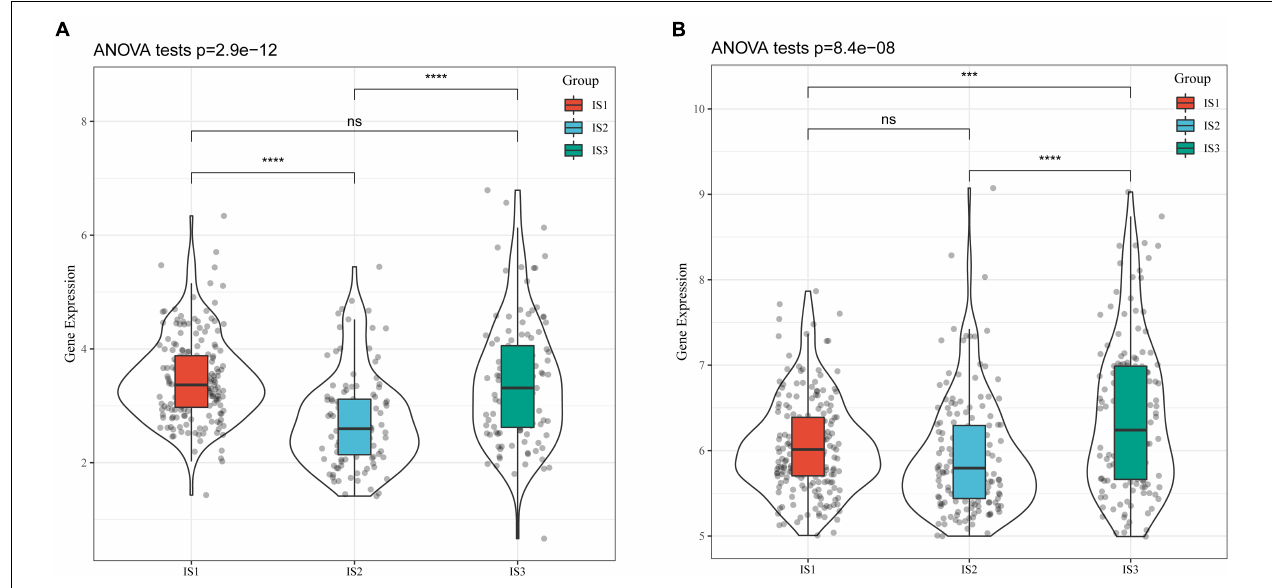
FIGURE 4 | Differential analysis of tumor markers in different immune subtypes. (A) Differences in the expression of CA199 in each subtype of the TCGA-COAD cohort; (B) Differences in the expression of CA199 in each subtype of the GSE39582 cohort; * P < 0.05, ** P < 0.01, *** P < 0.001, **** P <